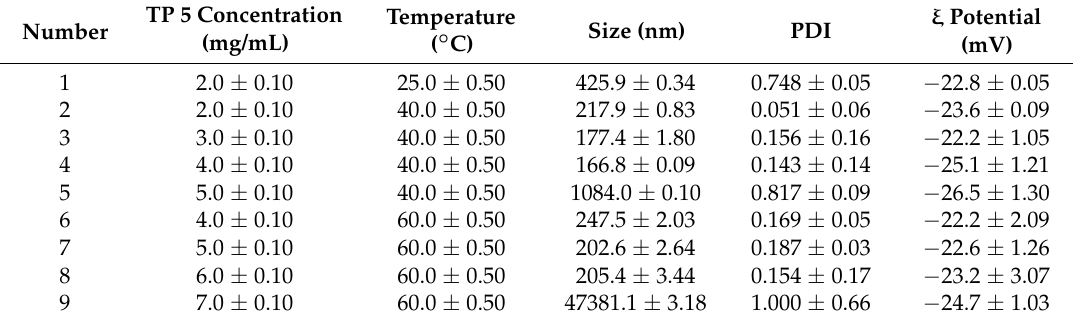
Table 3. The optimum parameters of preparing TP 5 -NPs, data represent as mean ± SD (n =